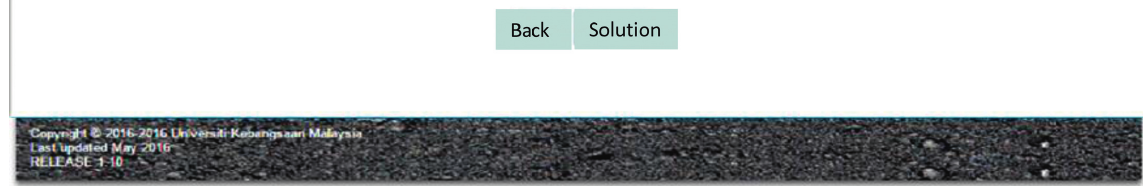
Figure 7: Screenshot of the combined distress problem